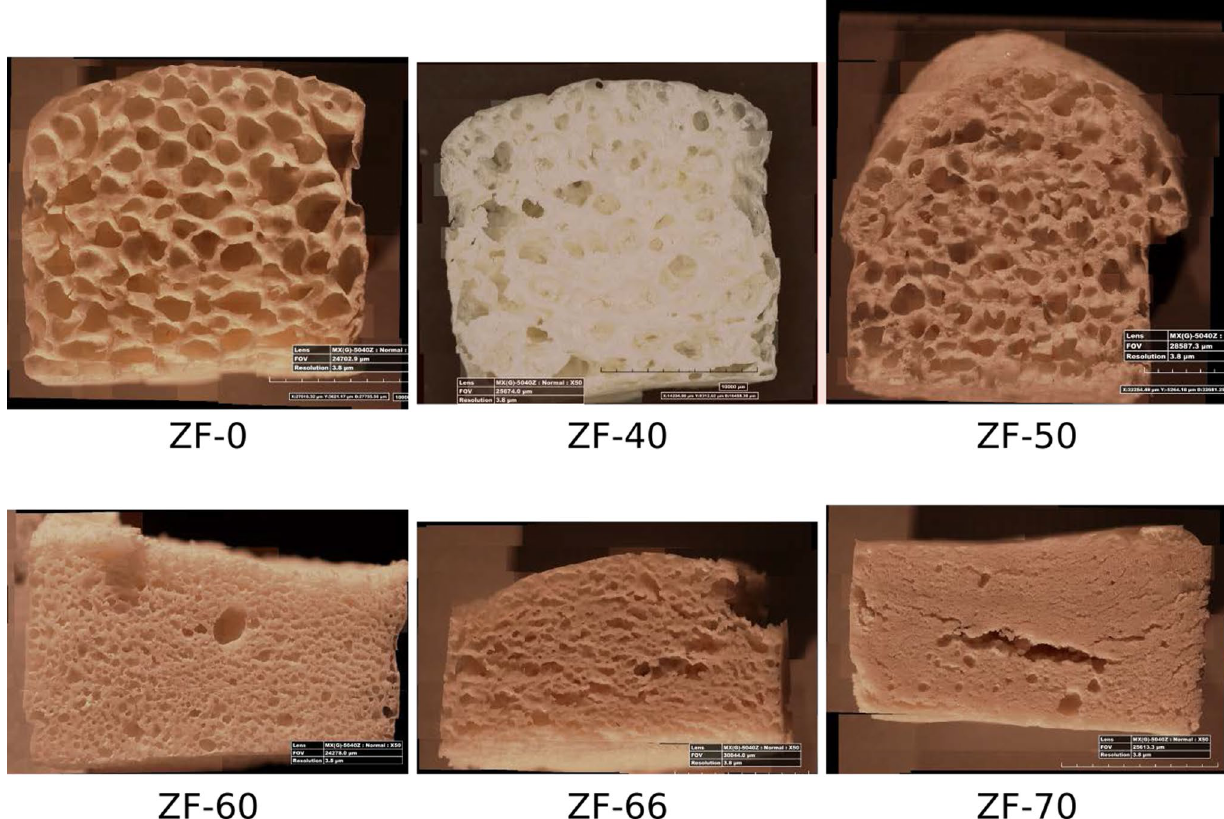
Fig. 4 Cross section image of all